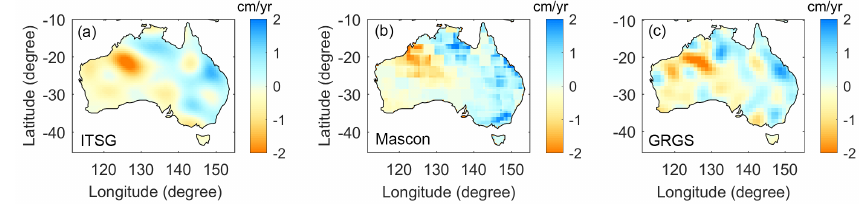
Figure 7. Long-term trends of GRACE-derived (cid:49) TWS from ITSG-DDK5 (a) , mascon (b) , and GRGS solution (c) .